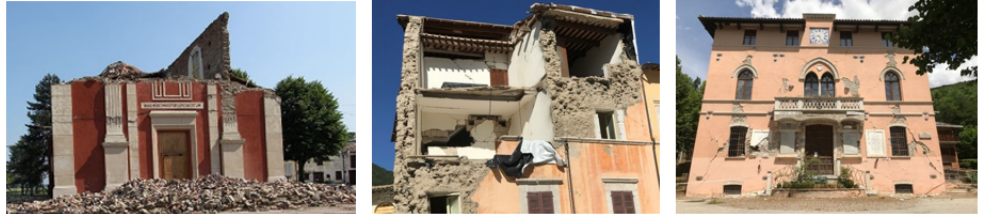
Figure 1. Example of masonry buildings damaged in recent earthquakes in